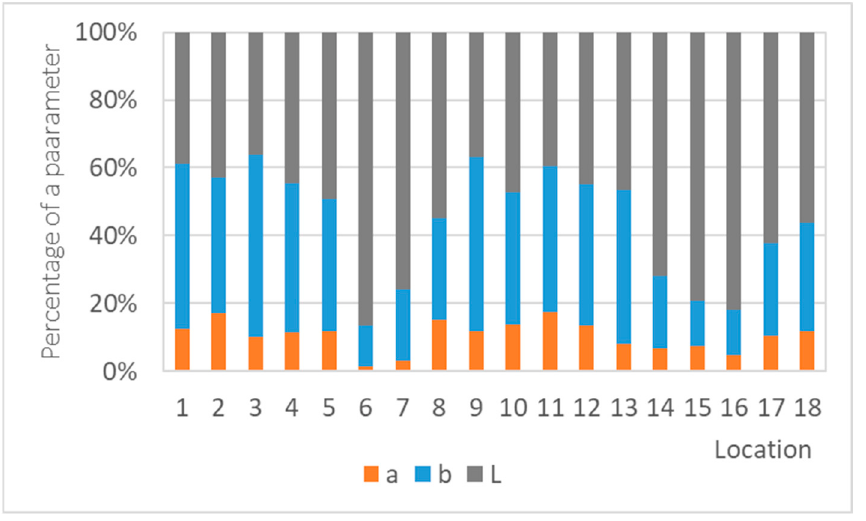
Figure 20. Percentage of the color parameters in the total color difference of copper coupons exposed for a year.